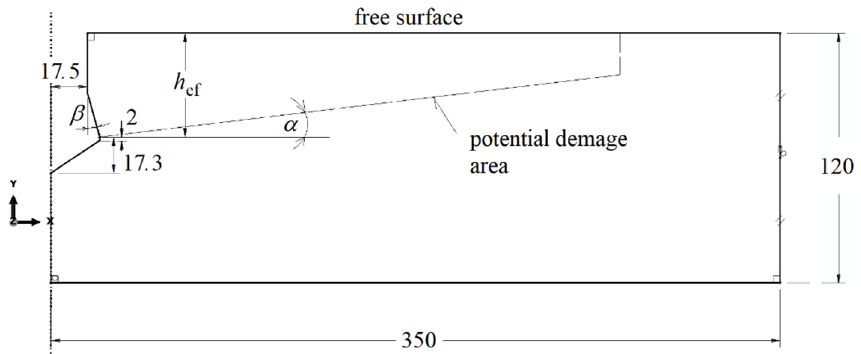
Figure 5. Axisymmetric model of anchor head interaction with rock, M20 anchor, dimensions in [mm].